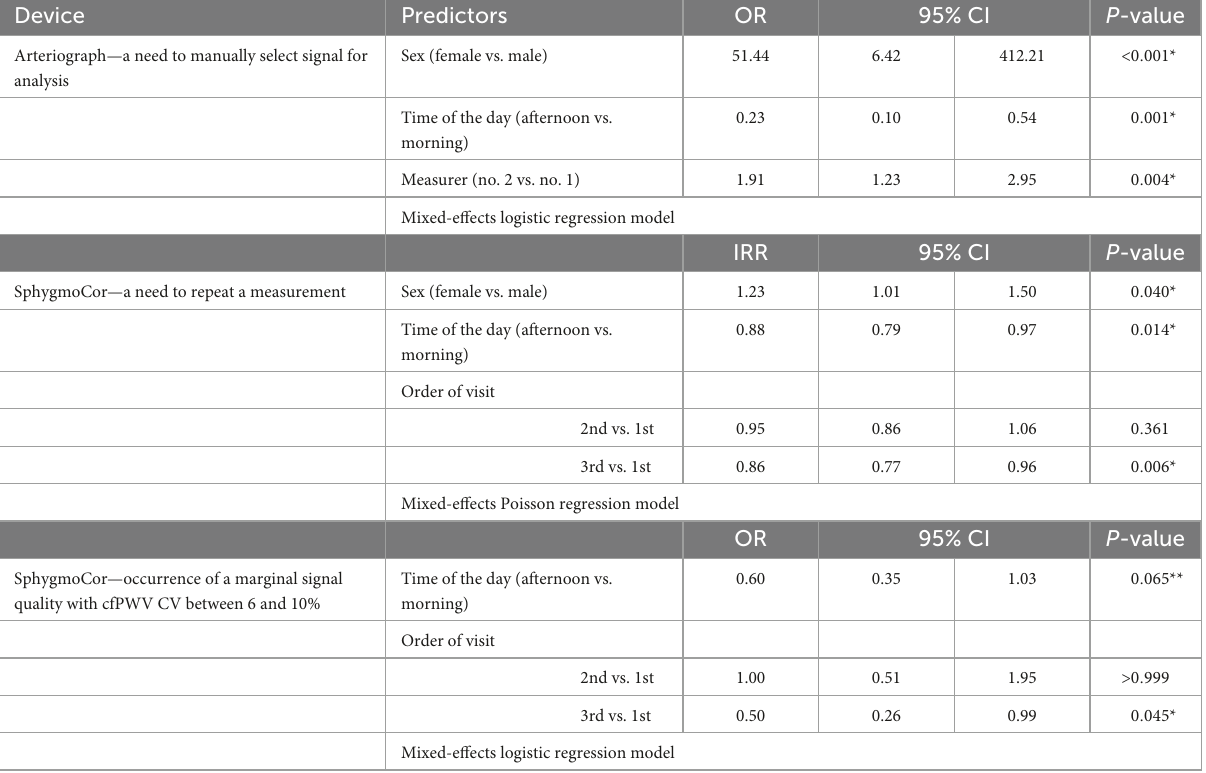
TABLE 3 Predictors of the measurement difficulties for Arteriograph and SphygmoCor